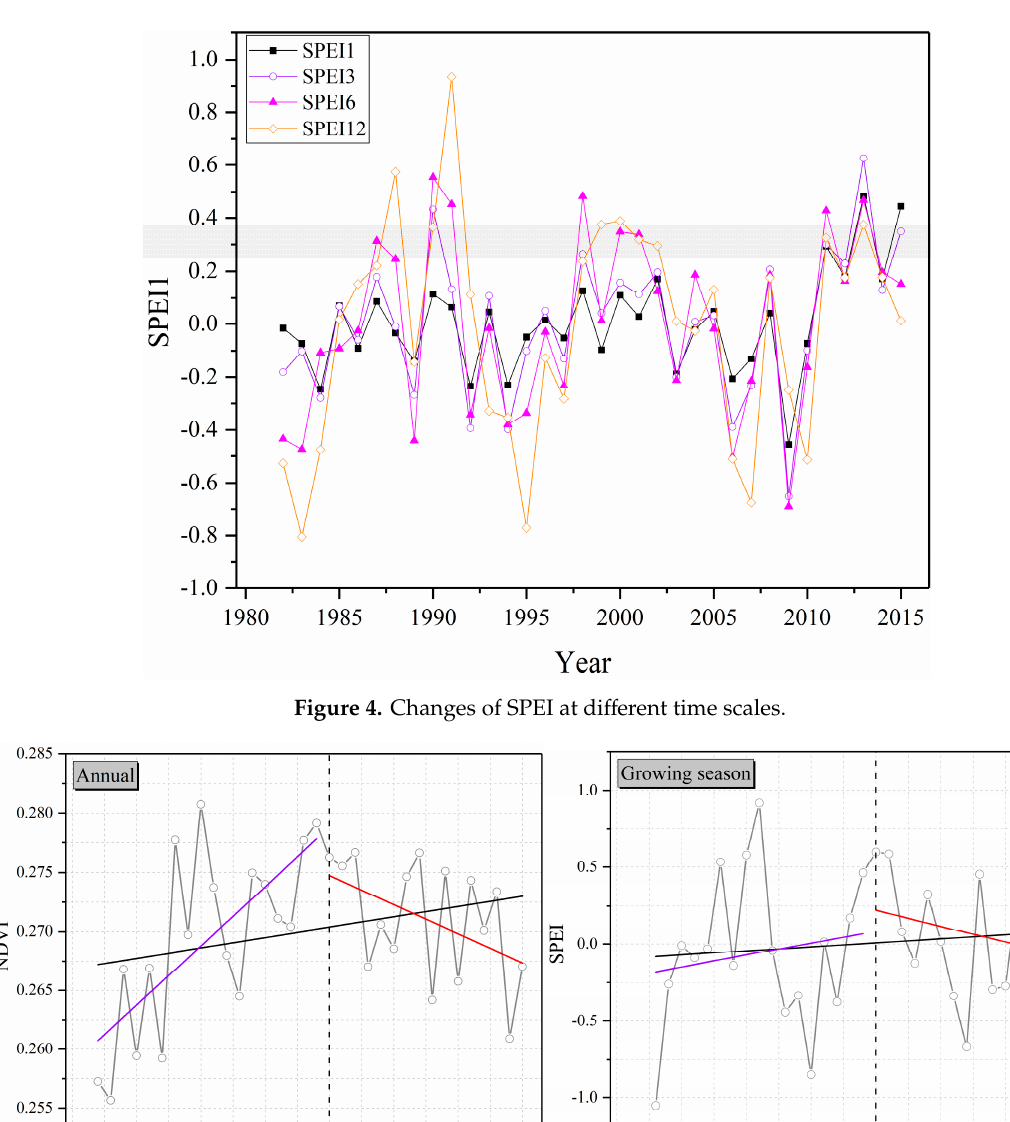
Figure 3 . Spatial performance of the measured and GLDAS-NOAH precipitation (left) and temperature (right).